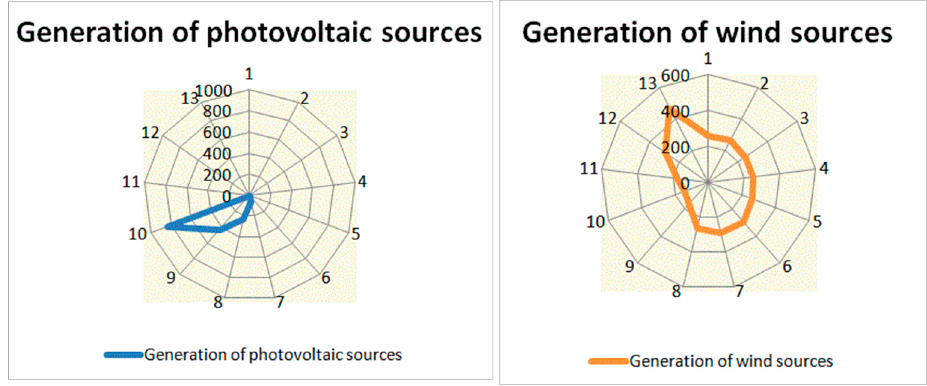
Figure 10. KSE operation—generation of wind and photovoltaic sources [47].